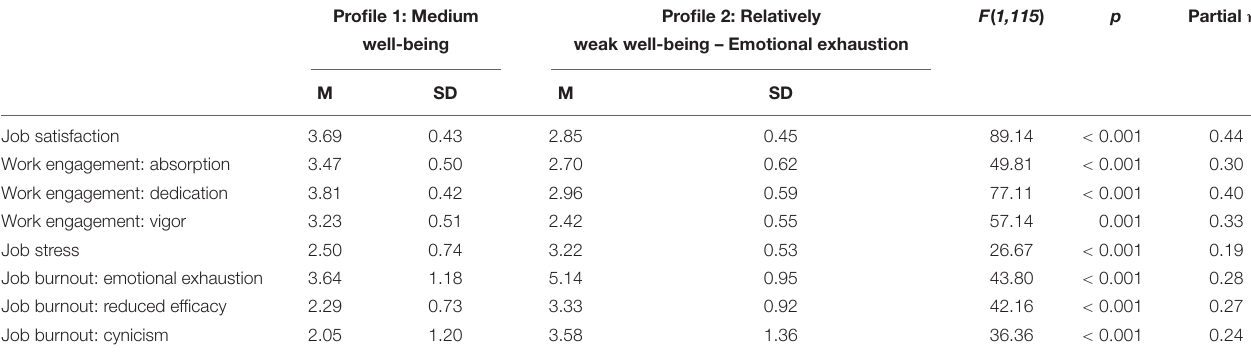
TABLE 4 | Means, standard deviations, and MANOVA tests for OWB indicators between the two profiles. Profile 1: Medium